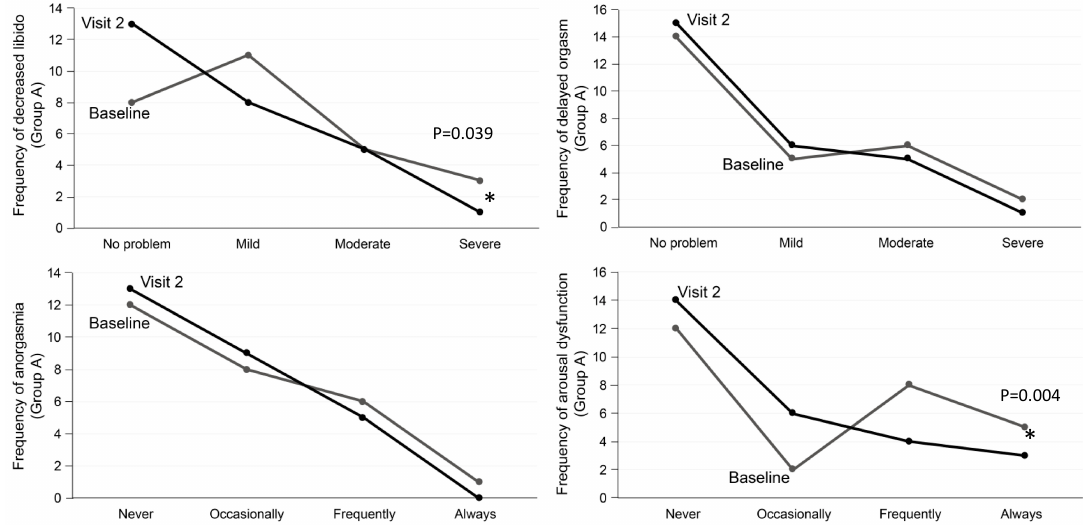
Figure 4. Group A. Desvenlafaxine-naïve patients. Changes in sexual functioning at follow-up.